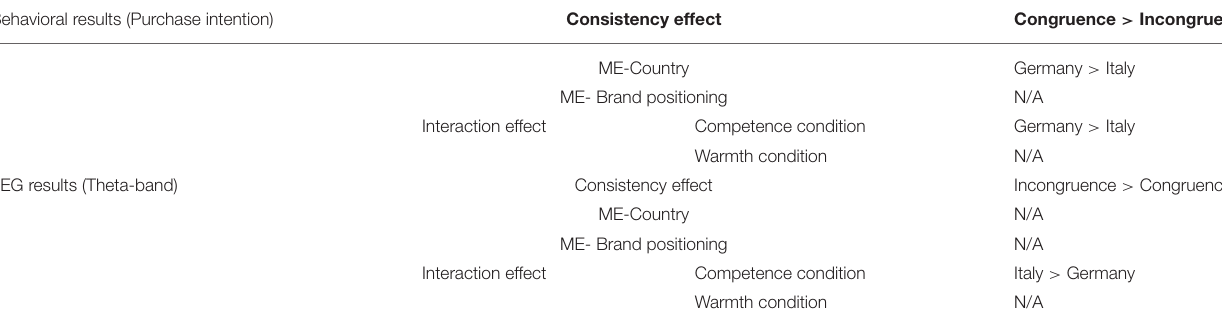
TABLE 2 | The results of behavioral and